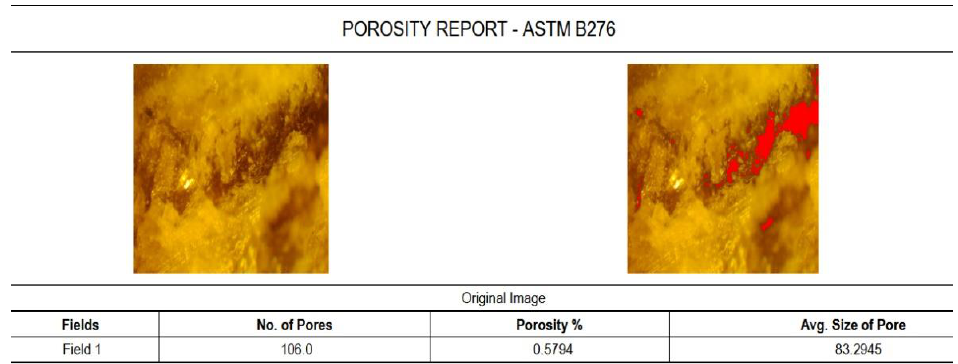
Figure 4. The report of porosity for Ruschita marble made with Material Plus software. As it appears from the analyzes, the marble has a good porosity (Figure 4) and a small number of inclusions (Table 1).